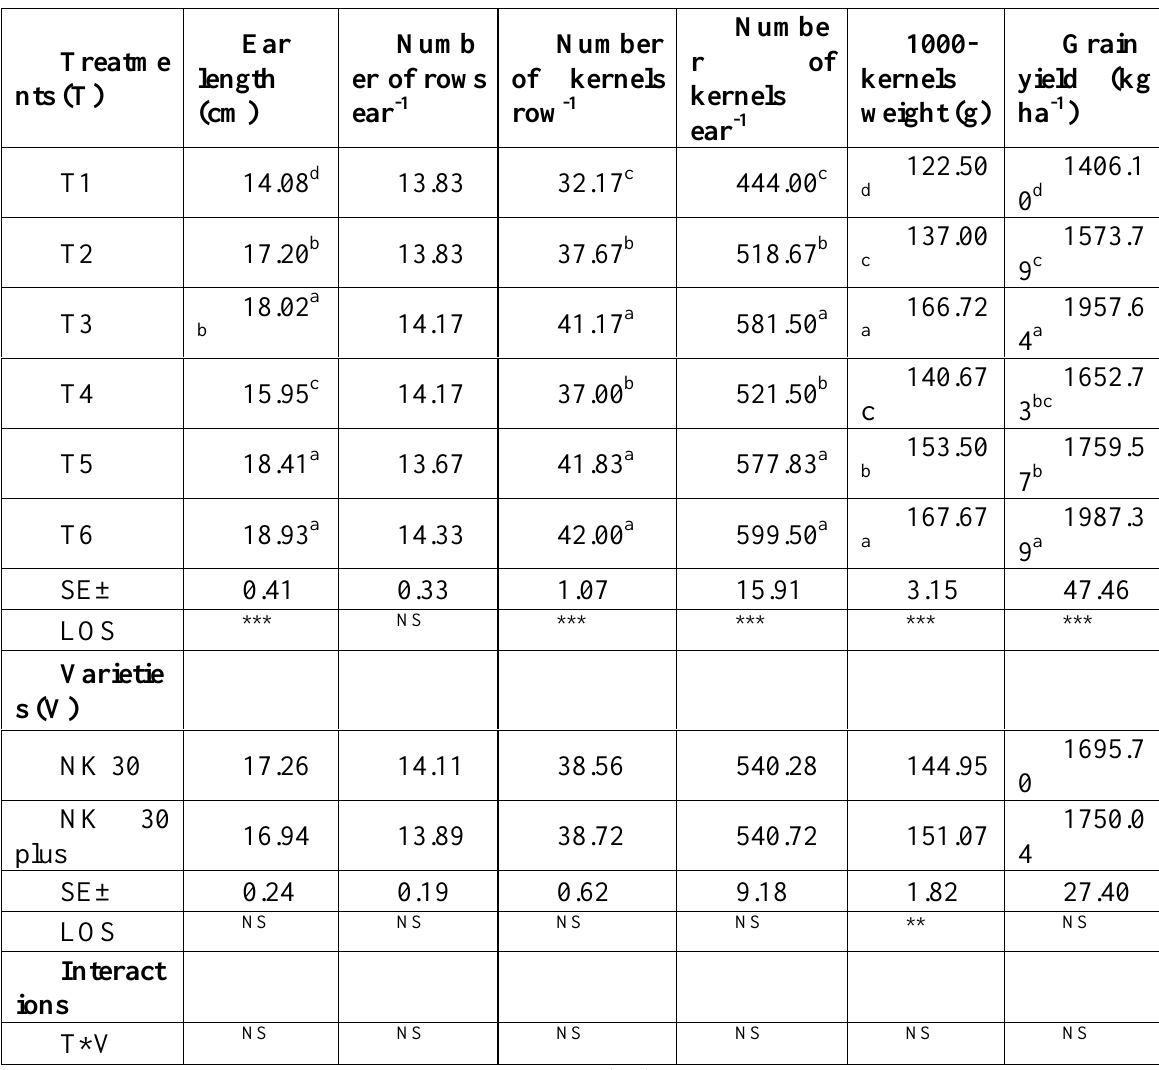
Table 2. Effects of biofertilizers, chemical fertilizers, and maize hybrids on the mean of yield attributing